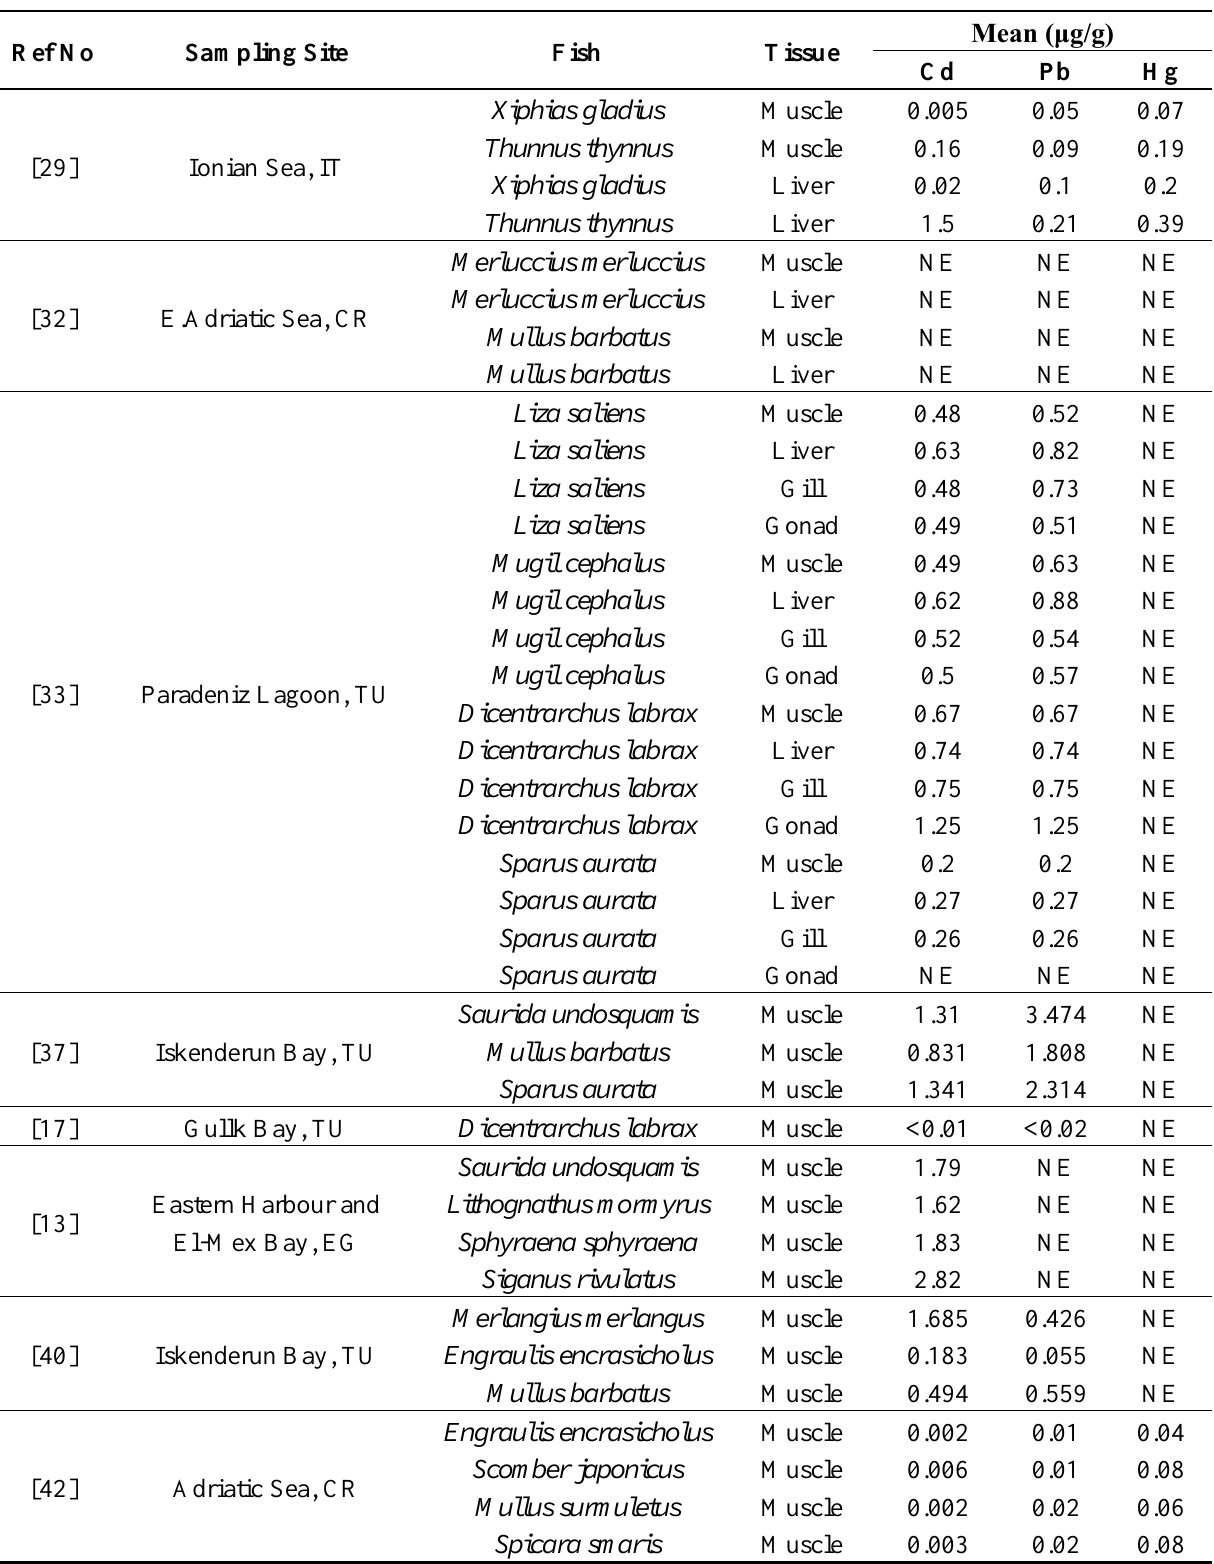
Table 3. Mean levels of Cd, Pb and Hg in fish tissue (μg/g). Ref